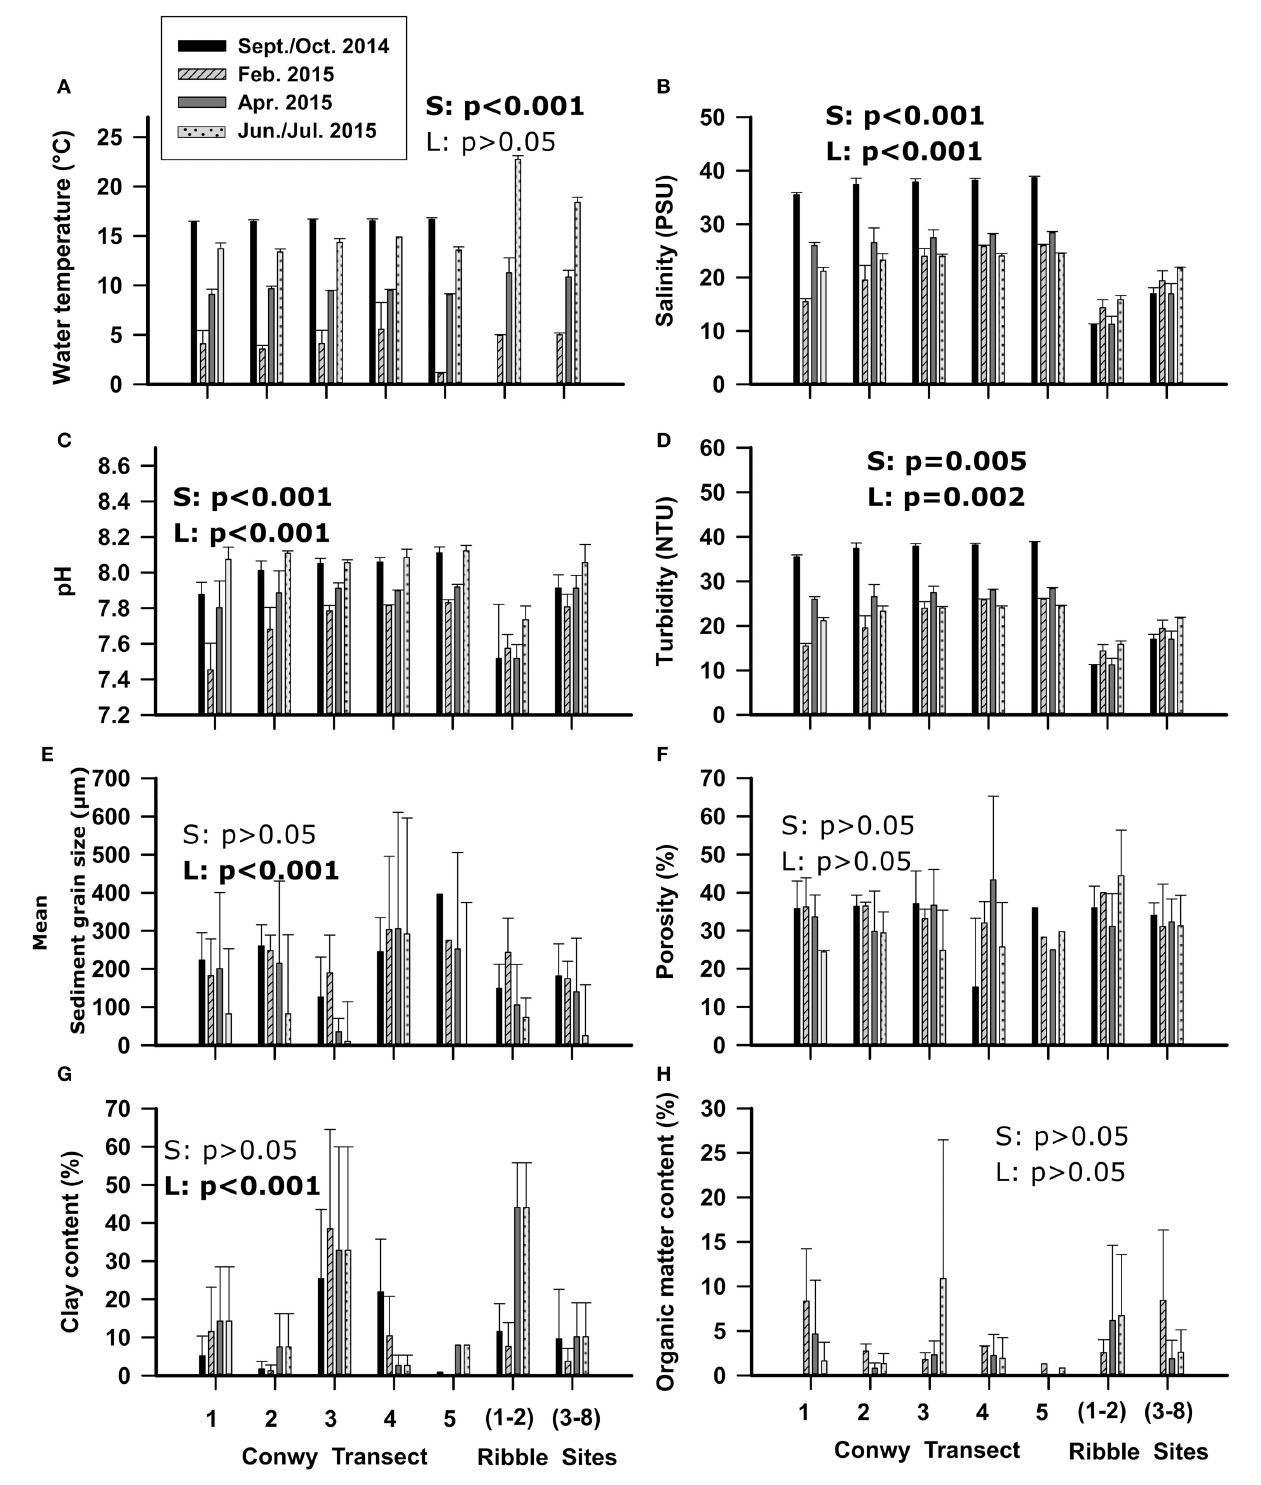
FIGURE 2 | Physicochemical variables of the water (A–D) and sediment (E–H) of the Conwy estuary from south (transect 1) to north (transect 5) and Ribble estuary from east (sites 1–2) to west (sites 3–8). Mean ± standard deviation. Statistical results of Welch’s t -test are presented within graphs, with S, effect of season; L, effect of location (Conwy transects and Ribble sites). Significant results are shown in bold.